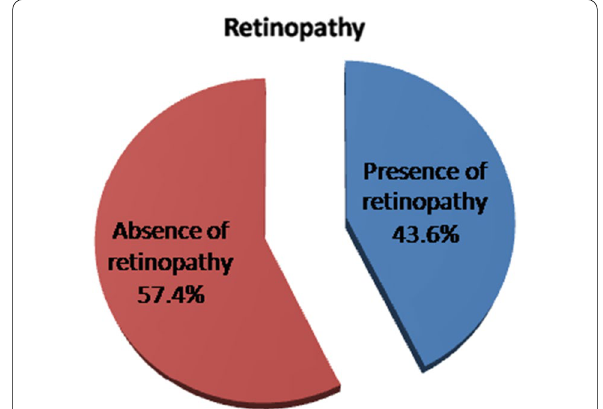
Fig. 1 The frequency of diabetic retinopathy among Sudanese patients with type 2 diabetes mellitus (expressed in percentages, n 115) =